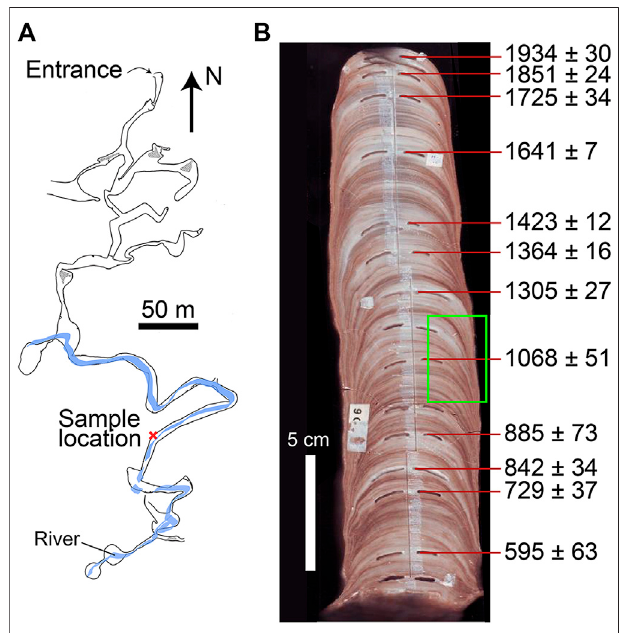
FIGURE 1 | (A) Map of the Pau D ’ Alho cave and (B) optical image of the ALHO6 stalagmite sample. Green region in panel (B) indicates the age range studied in thiswork. Hashed patchesin panel (A) denote collapsedrock